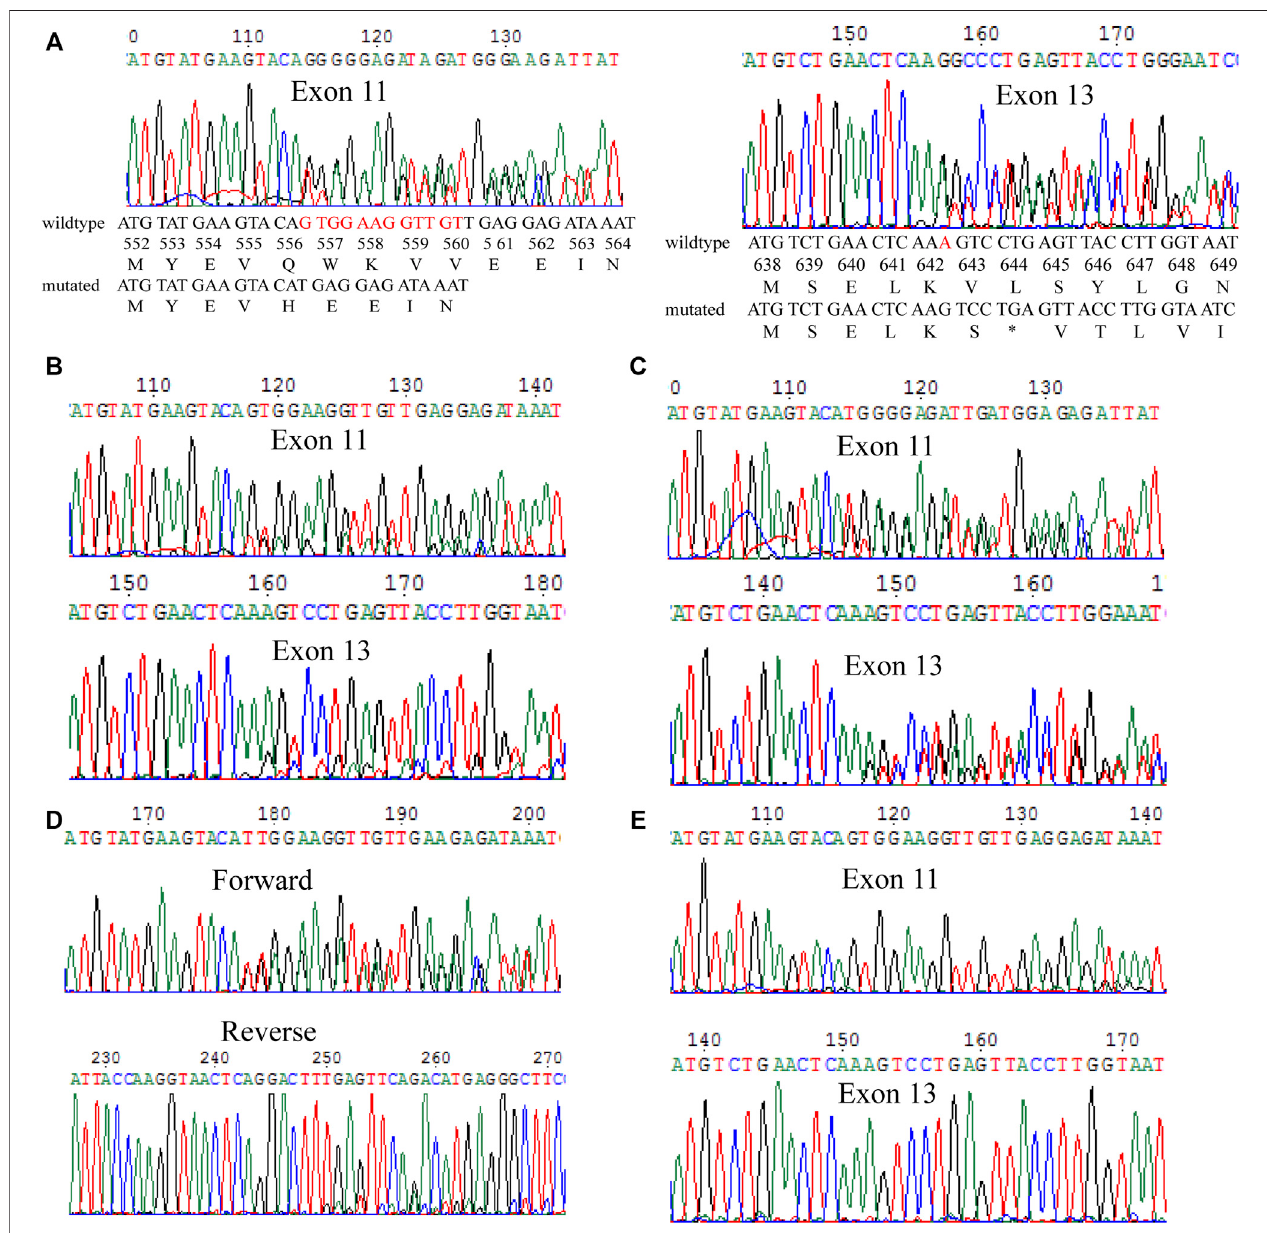
FIGURE 2 | Mutation analysis of the c-KIT gene in different specimens. (A) Biopsy specimen of the primary tumor. c-KIT c.1668_1679del GTGGAAGGTTGT mutationinexon11andc.1926delAmutationinexon13weredetected.Themutatednucleotidesareshowninredcolors. (B) Primarytumoraftersurgicalresection.The same mutations were found in this specimen through biopsy. (C) Metastatic tumor after surgical resection. Similarly, the two mutations were detected in this metastatic tumor. (D) Detection of the two mutations in surgically primary tumor specimen in a transacting manner. (E) Normal marginal tissue matched with the recurrent tumors. The two mutations showed a wild type in the normal